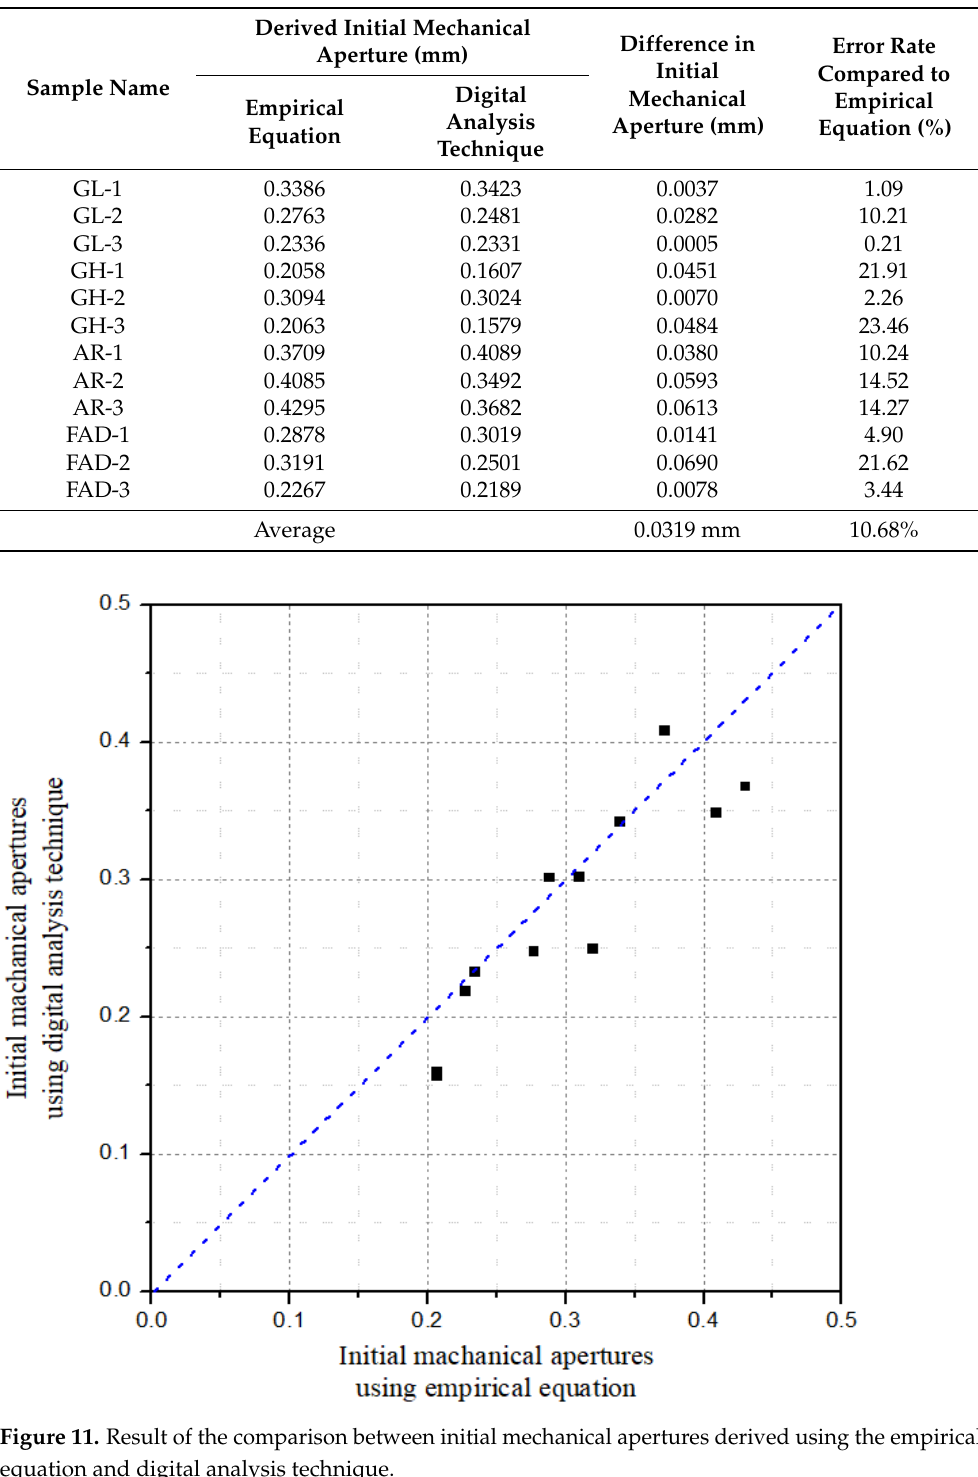
Figure 11. Result of the comparison between initial mechanical apertures derived using the empir- ical equation and digital analysis